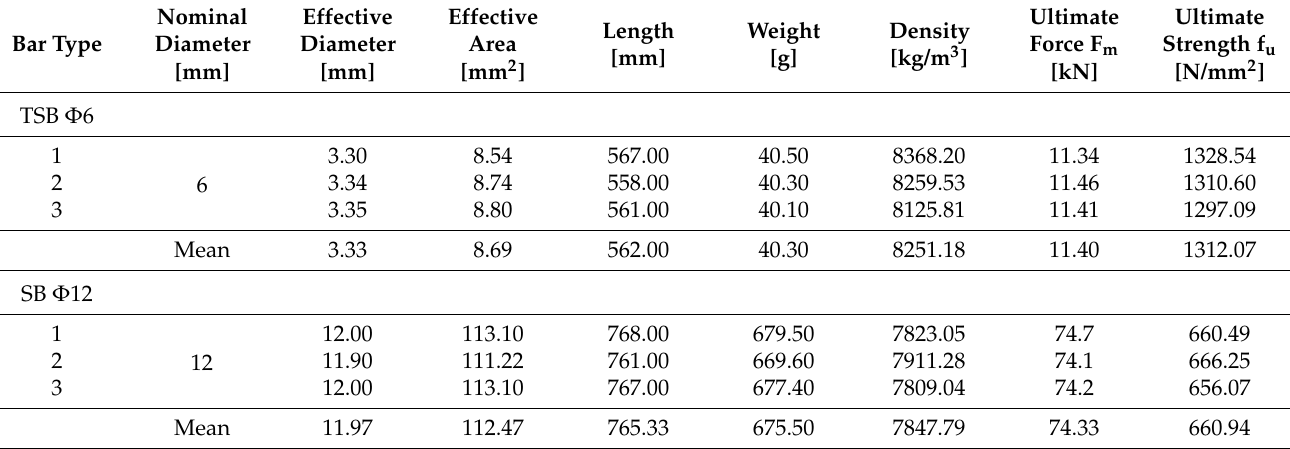
Table 5. Reinforcing bars